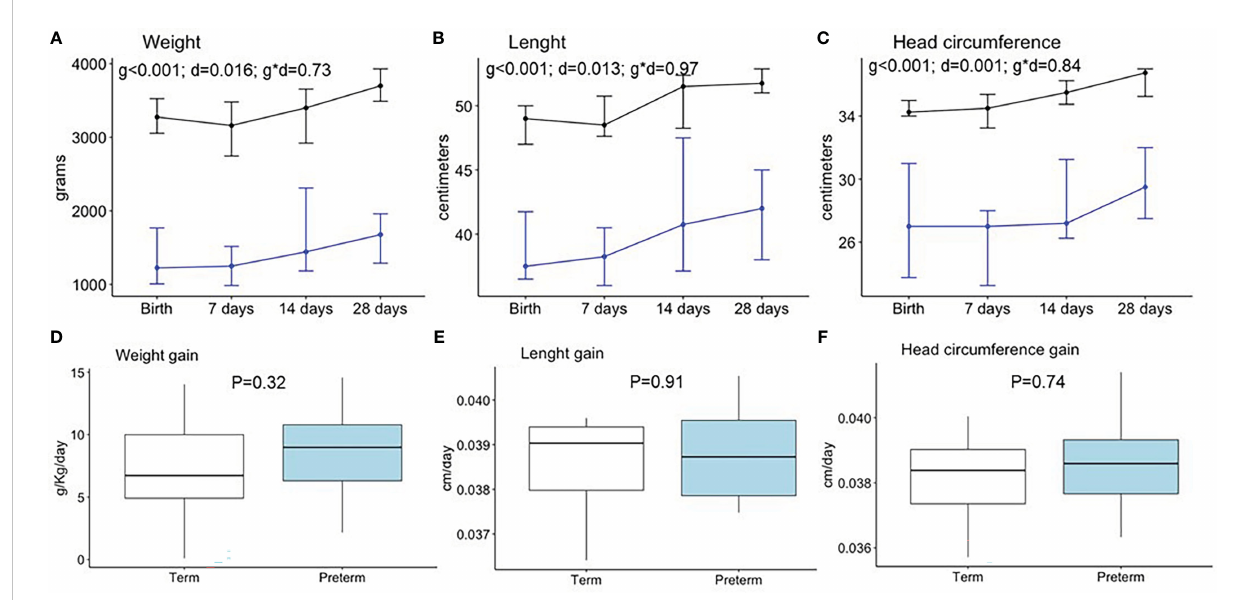
FIGURE 2 Neonatal anthropometry pattern during the fi rst month of life in weight (A) , length (B) , and head circumference (C) and weight gain (D) , length gain (E) , and head circumference gain (F) . Data show the median and interquartile range [Q1; Q3]. Black lines show term infants (Birth n=30, 7 days n=22, 14 days n=17, 28 days n=15), and blue lines show preterm infants (Birth n=18, 7 days n=15, 14 days n=13, 28 days n=12). In the two way-ANOVA, the following were considered as factors: preterm/term (group = g), birth/7days/14 days/28 days (day = d), and interaction effect group and day (g * d). The P-value (P) was extracted by the Mann – Whitney U test in the